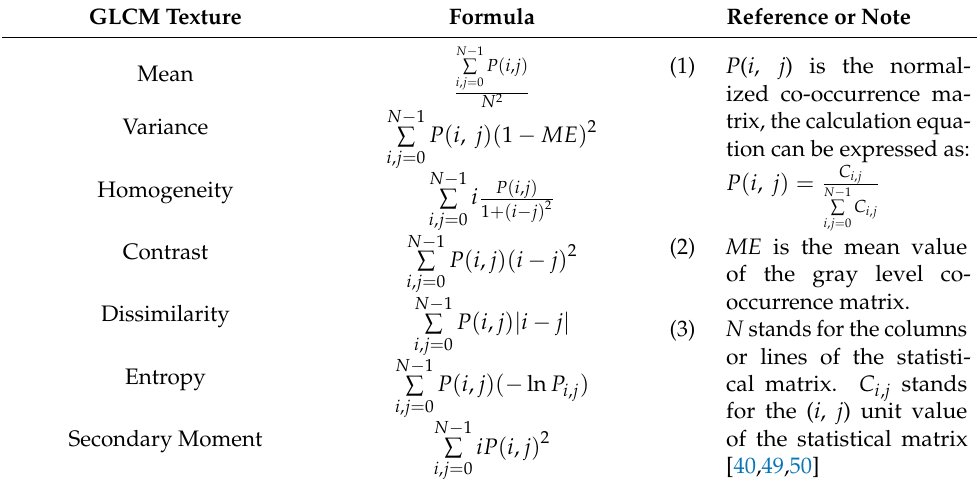
Table 2. Textural features for the CART decision tree